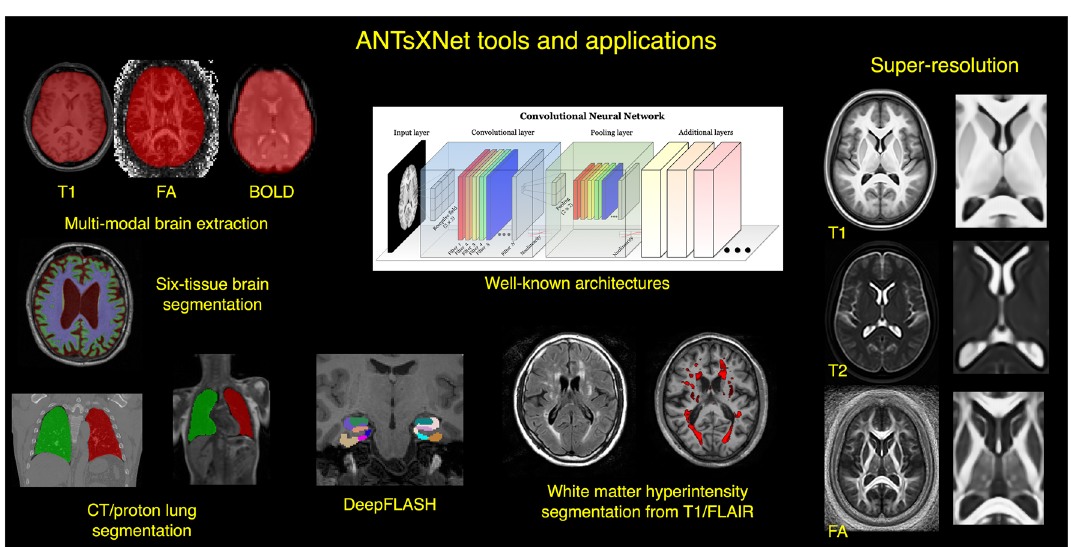
Figure 1. An illustration of the tools and applications available as part of the ANTsRNet and ANTsPyNet deep learning toolkits. Both libraries take advantage of ANTs functionality through their respective language interfaces—ANTsR (R) and ANTsPy (Python). Building on the Keras/TensorFlow language, both libraries standardize popular network architectures within the ANTs ecosystem and are cross-compatible. These networks are used to train models and weights for such applications as brain extraction which are then disseminated to the public.